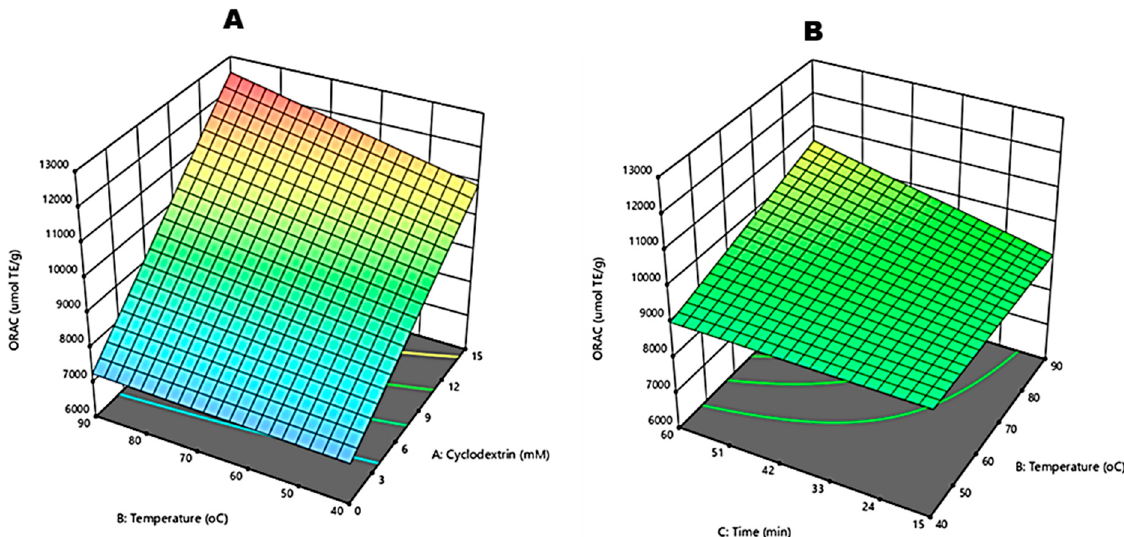
Figure 7. Response surface plots for independent variables on the oxygen radical absorbance ca- pacity (ORAC) of crude green rooibos extracts. Effect of reaction temperature and Beta-cyclodextrin ( A ) and effect of reaction temperature and time ( B ).